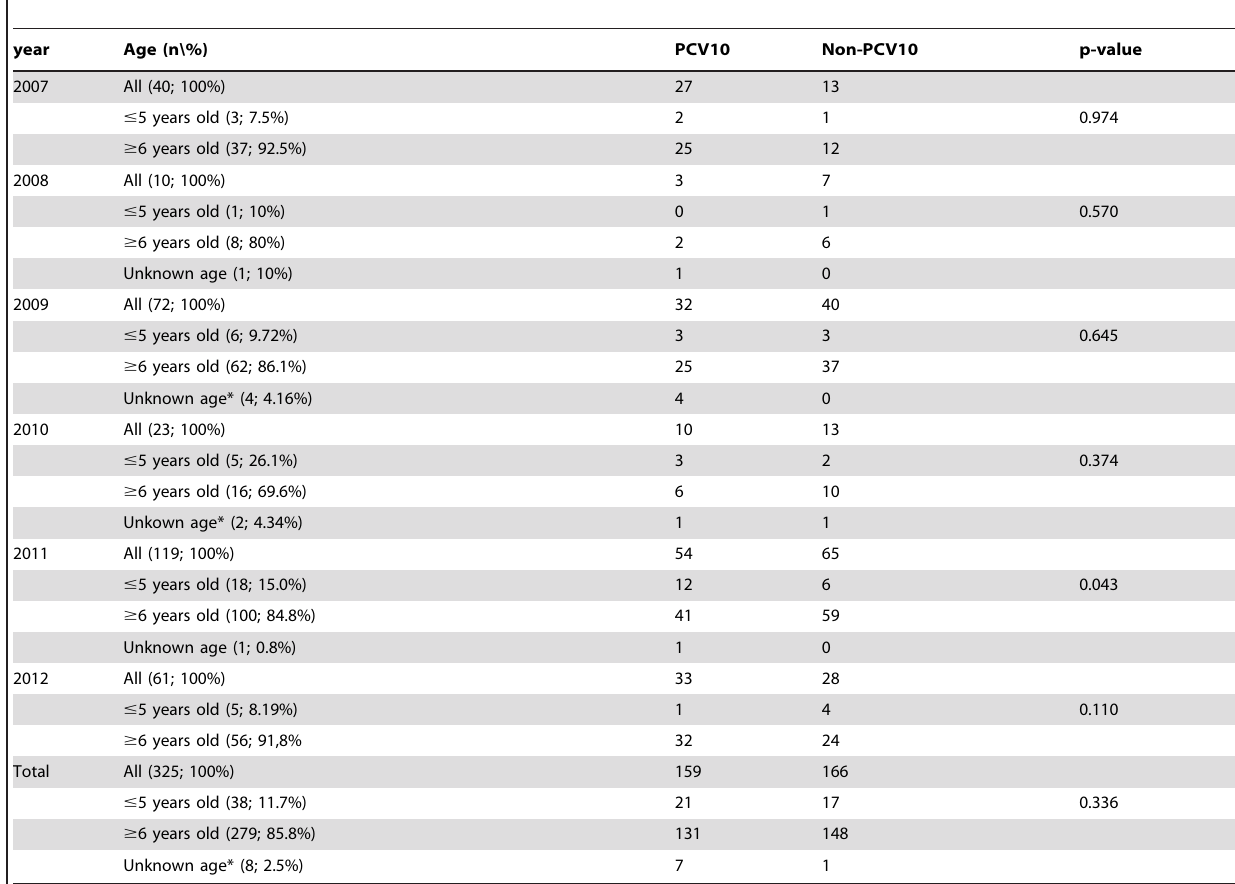
Table 2. PCV10 coverage over the years of the study (2007–2012), considering epidemiologically relevant age